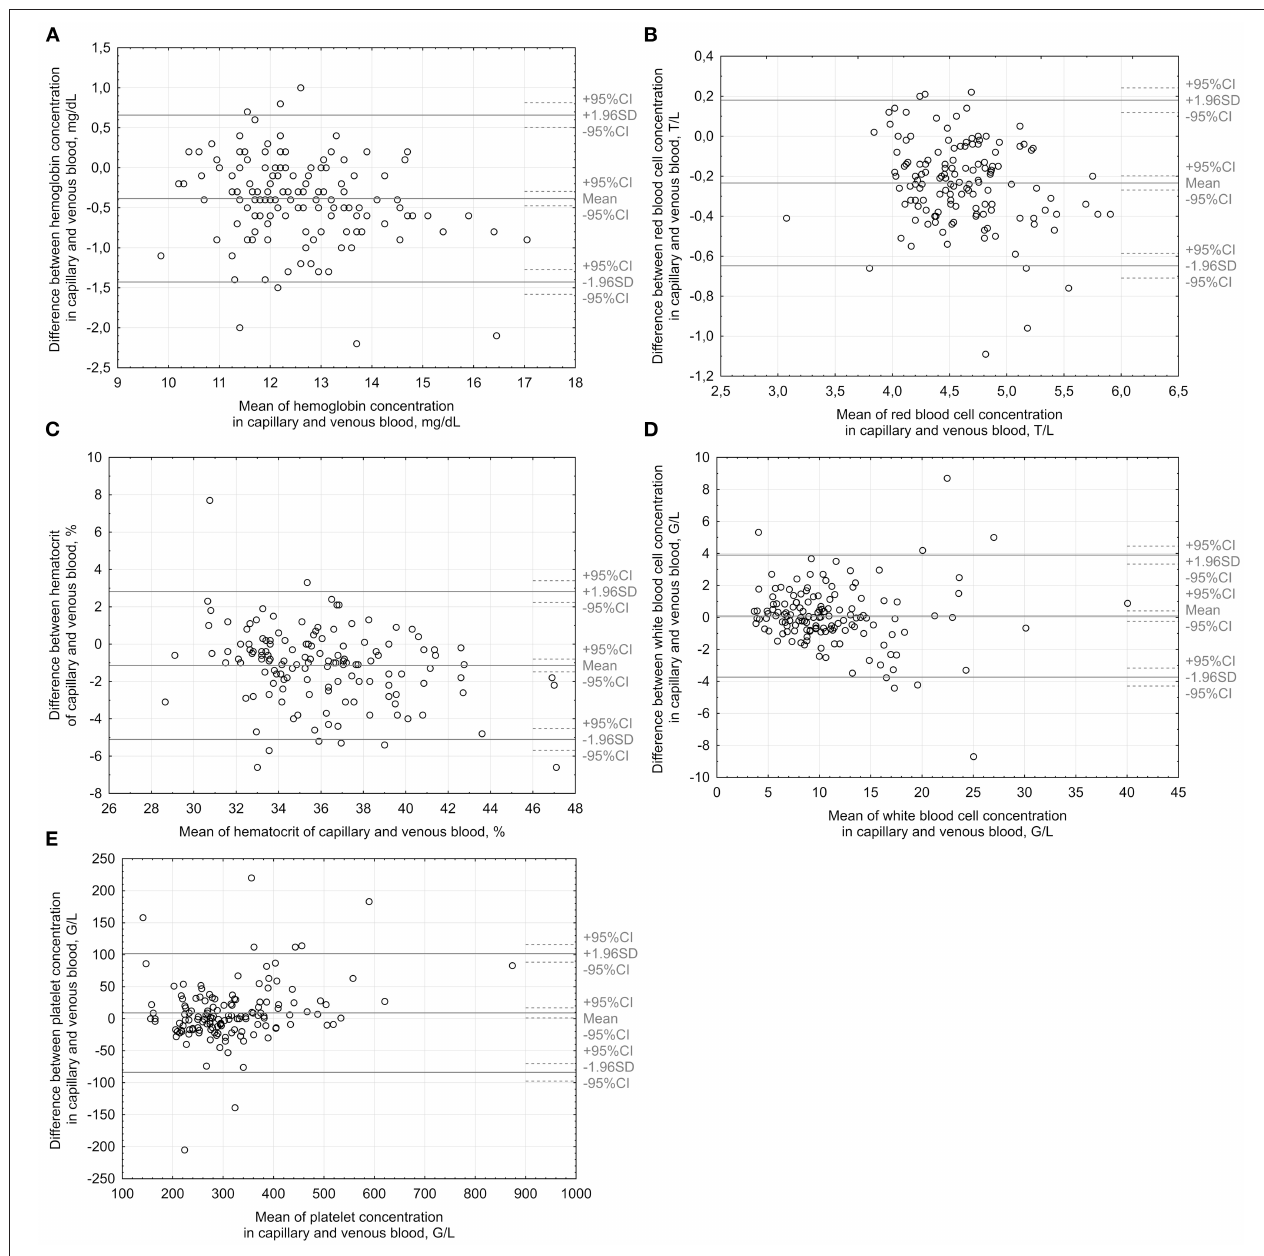
FIGURE 1 | Bland-Altman plots illustrate the agreement between capillary and venous measurements of hemoglobin (A) , red blood cells (B) , hematocrit (C) , leukocytes (D) and platelets (E) . 1 G/L = 1 000/ µ L; 1 T/L = 1 000 000/L.